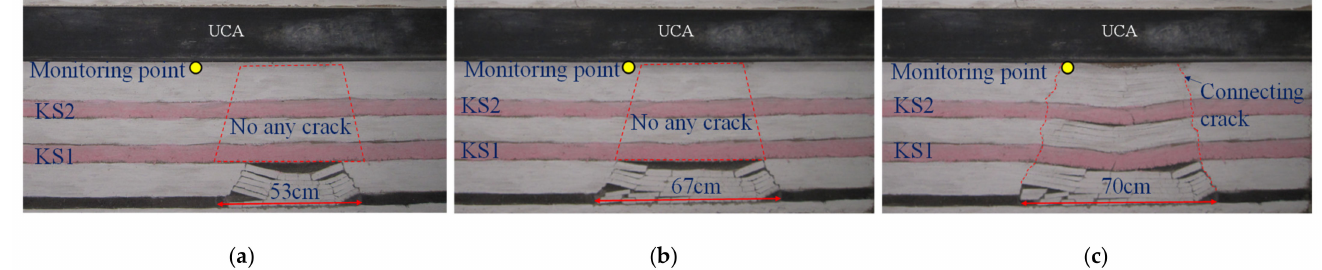
Figure 6. Strata breakage and movement between the scenarios with UCA: ( a ) advance 53 cm; ( b ) advance 67 cm; ( c ) KS broken.